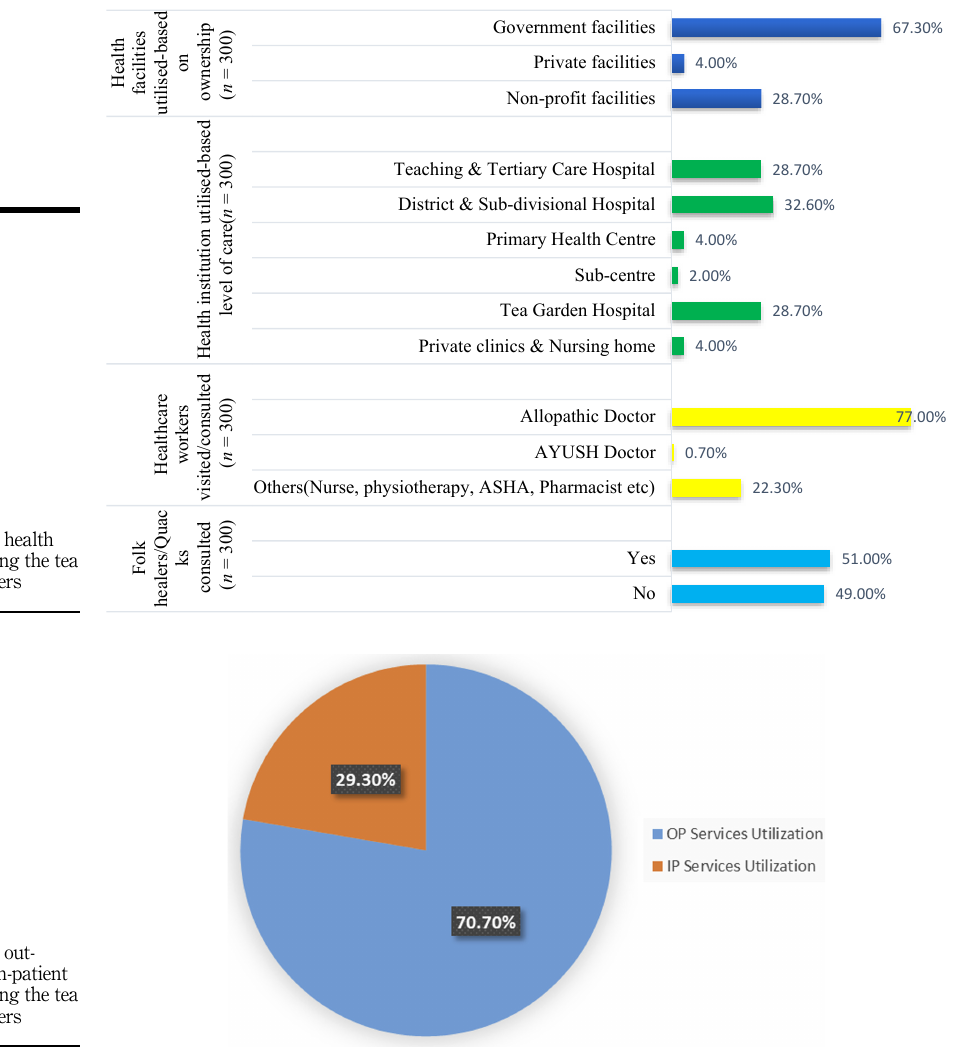
Figure 2. Utilisation of out- patient and in-patient services among the tea garden